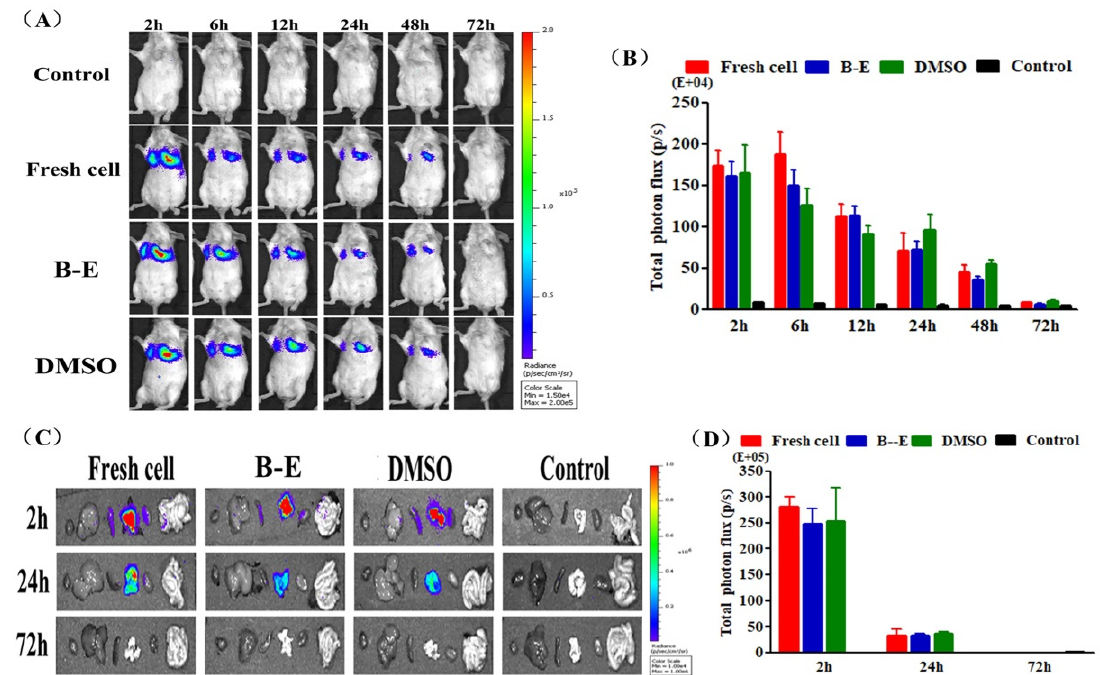
Figure 7. Influence of cryopreservation on in vivo distribution of GFP-Fluc-UCMSCs. ( A ) Bioluminescence images to monitor the in vivo distribution of GFP-Fluc-UCMSCs in mouse model. ( B ) Quantification of total photon flux from GFP-Fluc-UCMSCs in mouse model. ( C ) Bioluminescence images to monitor the distribution of GFP-Fluc-UCMSCs in mouse organs. The organs were arranged as heart, liver, spleen, lung, kidney, and intestines. ( D ) Quantification of total photon flux from GFP-Fluc-UCMSCs in mouse organs. Control group refers to UCMSCs without cryopreservation and transgene treatment. Fresh cell refers to GFP-Fluc-UCMSCs without cryopreservation process. DMSO refers to GFP-Fluc-UCMSCs cryopreserved by traditional protocol based on DMSO. B–E refers to GFP-Fluc-UCMSCs cryopreservation using betaine combined with electroporation at optimum condition. Value = mean ± standard deviation, n = 4.